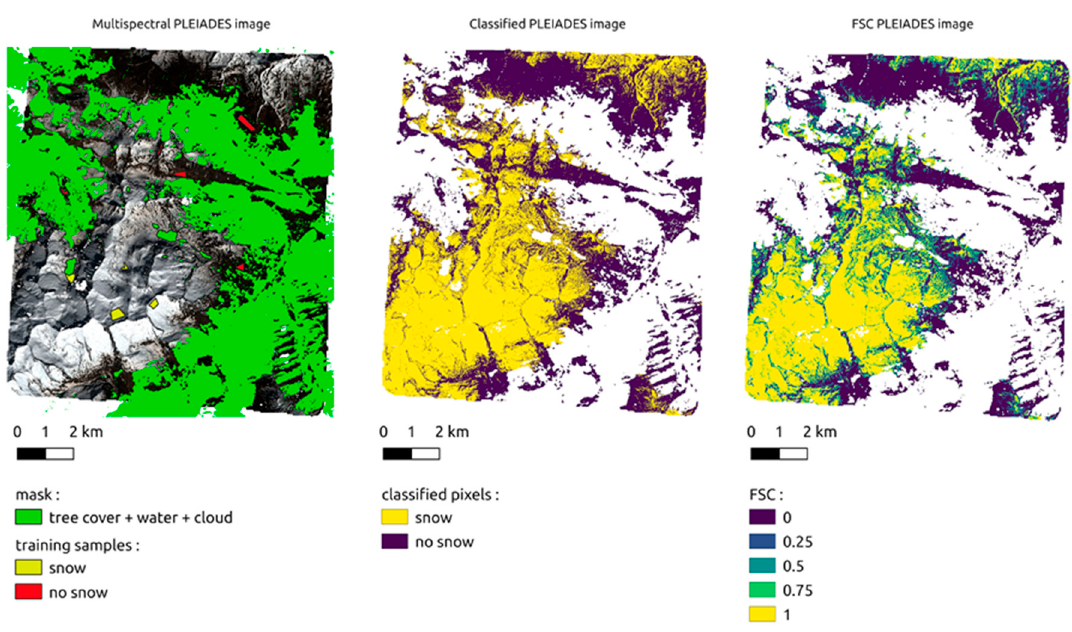
Figure 3. Illustration of the processing workflow from the Pléiades multispectral image to the reference FSC map.